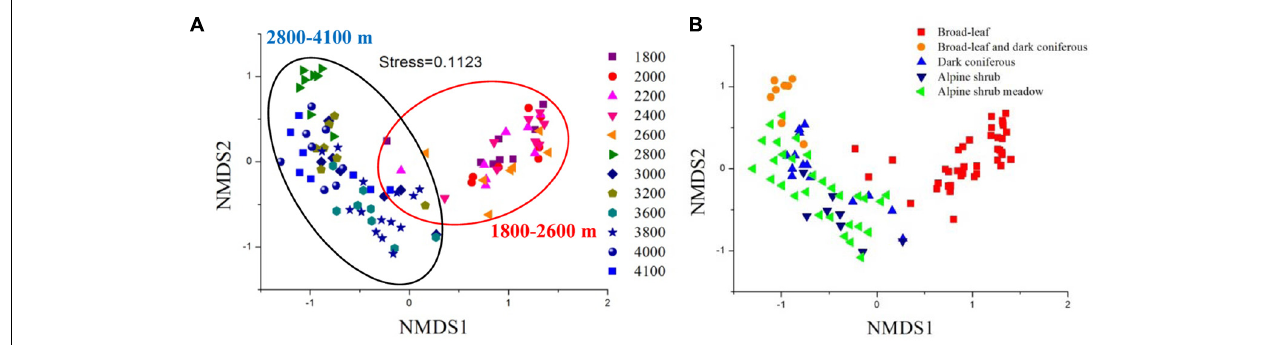
FIGURE 2 | Nonmetric multidimensional scaling (NMDS) analysis of bacterial community compositions from 12 sites across the elevational gradients, ranked by elevation (A) and vegetation type (B) . The compositional variation is represented by Jaccard distance based on the relative abundances of OTUs.